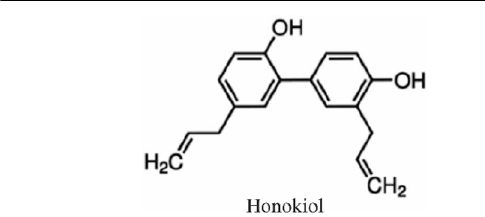
Fig. 8 Chemical structure of